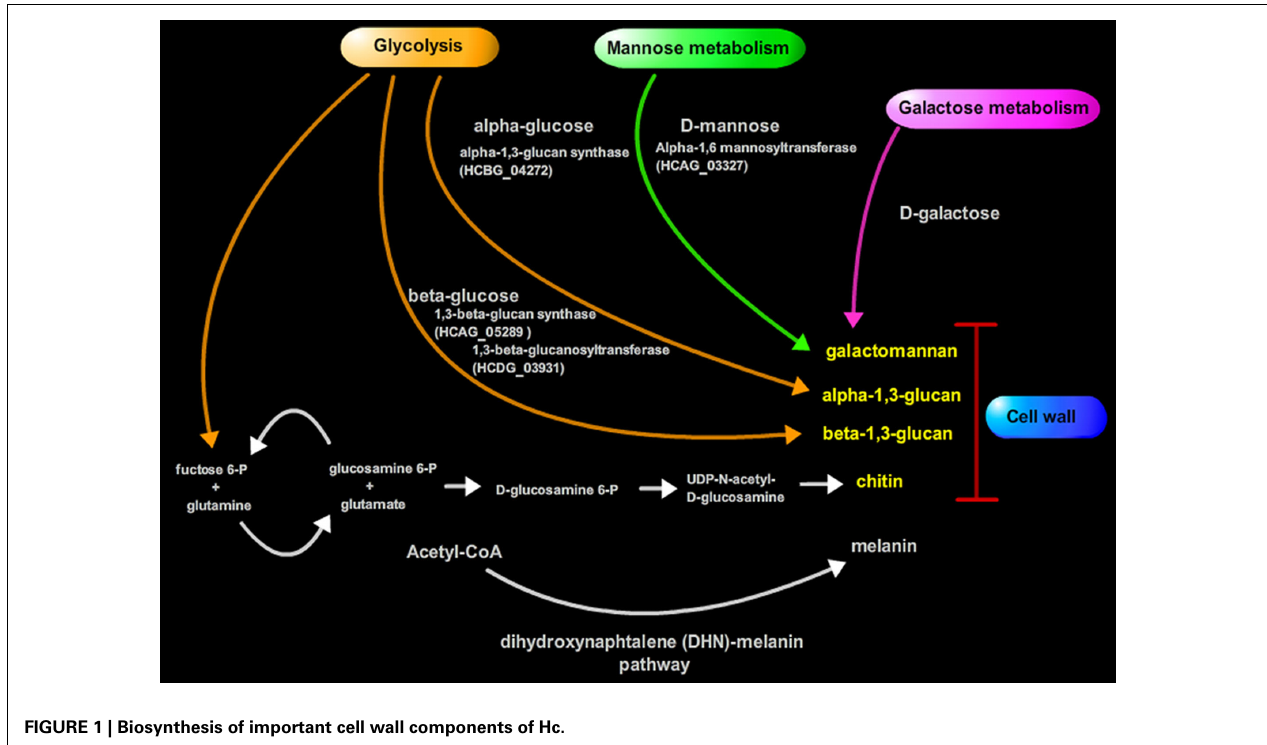
FIGURE 1 | Biosynthesis of important cell wall components of Hc.